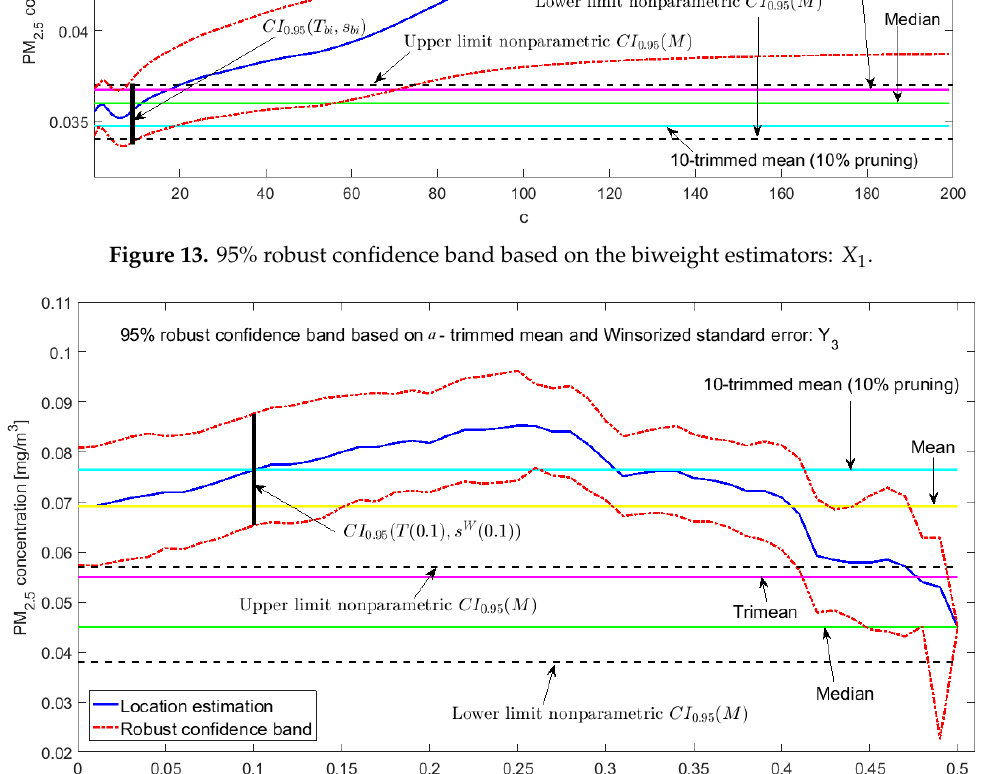
Figure 14. 95% robust confidence band based on the 𝑎 -trimmed mean and Winsorized standard error: 𝑌 (cid:2871) .